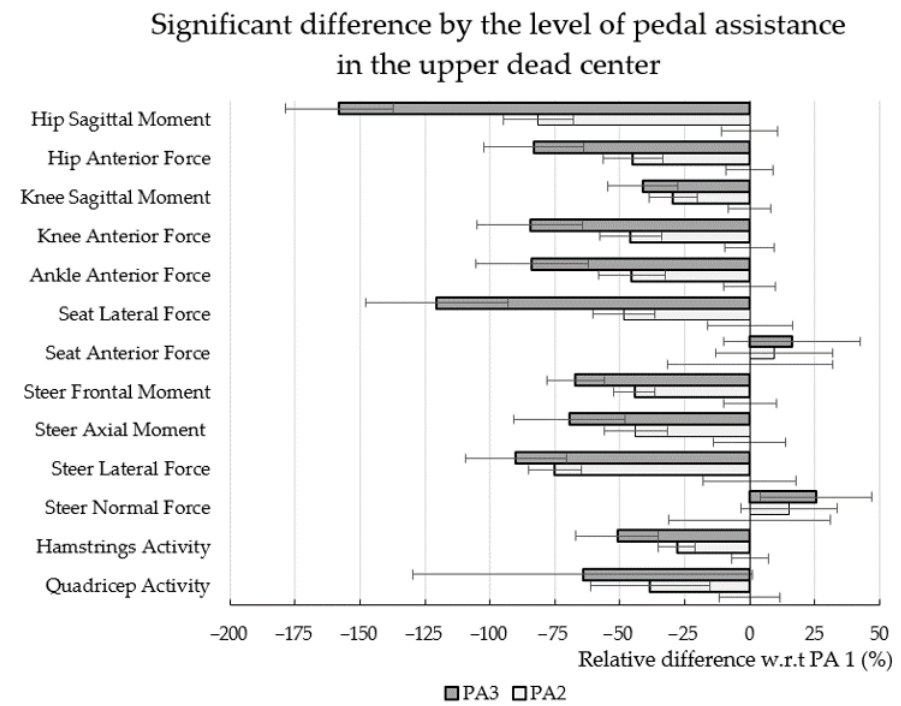
Figure 7. Significant differences based on the level of PA for the upper dead center.